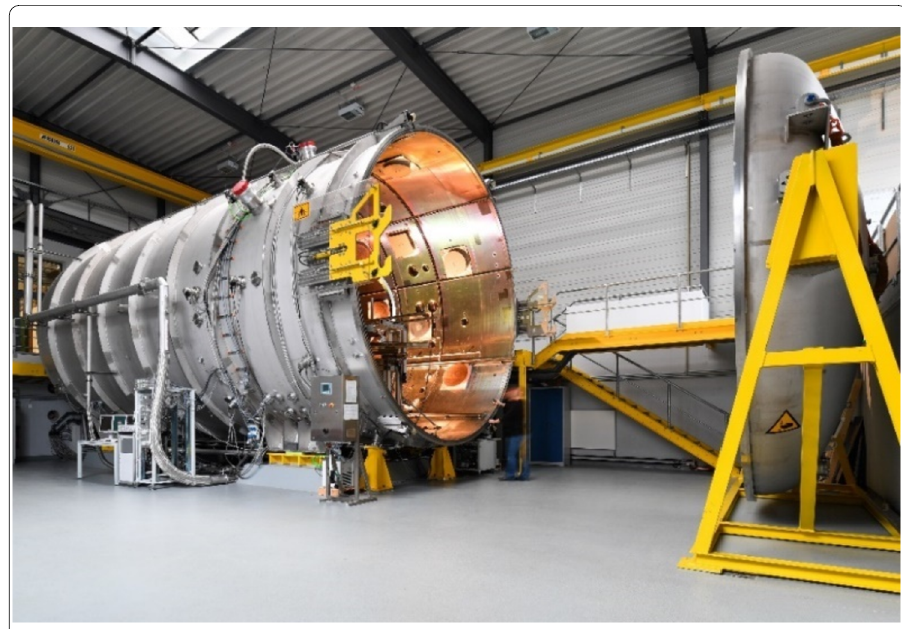
Figure 1 View of the STG-ET vacuum chamber with open door